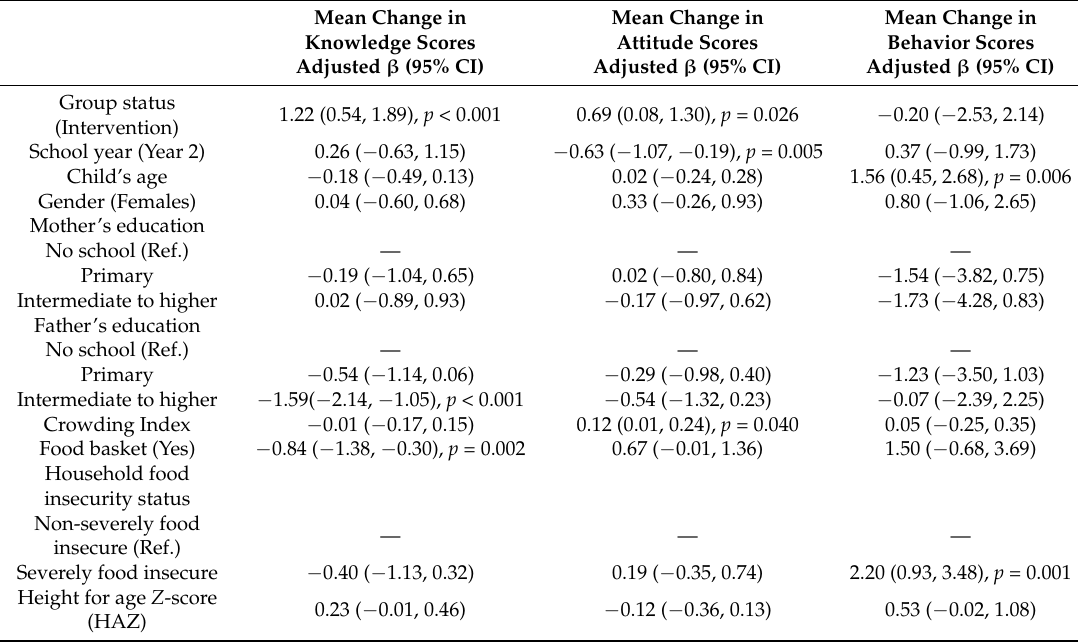
Table 3. General linear regression models for mean change in nutrition knowledge, attitude and behavior scores among school-aged children in the study sample † ( n =